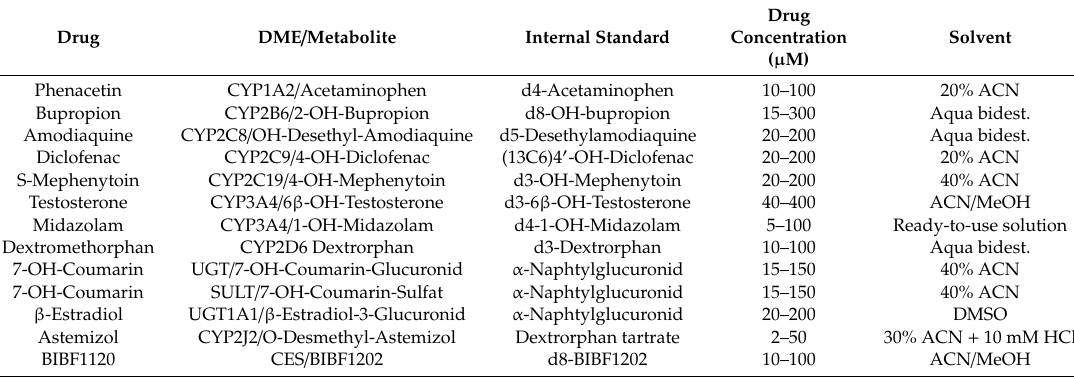
Table 1. Drugs applied for drug metabolizing enzymes (DME) activity